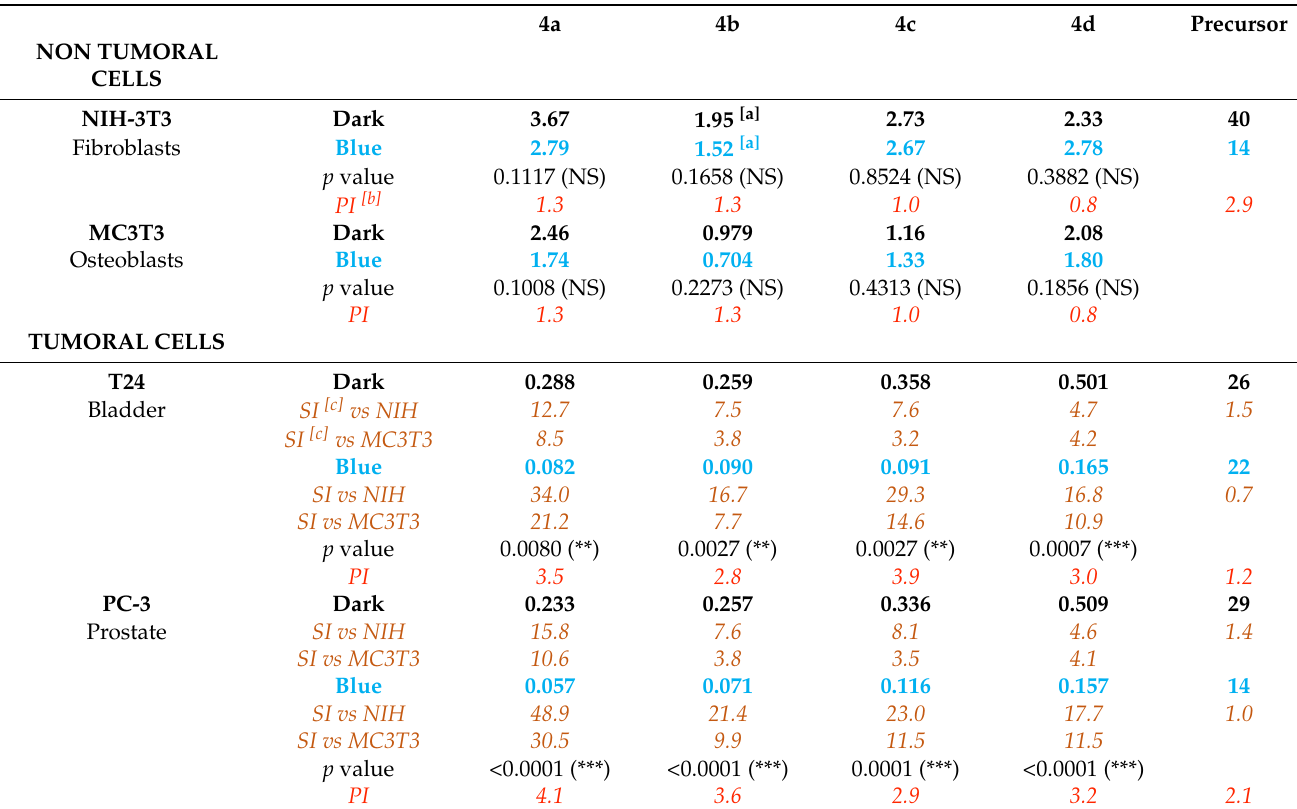
Table 2. Cytotoxicity and selectivity of complexes 4a to 4d on a panel of cancer cells (T24 bladder, PC-3 prostate, MCF7 breast, A549 lung and HeLa cervix) versus non-cancerous NIH-3T3 fibroblasts and MC3T3 osteoblasts (GI 50 ( µ M), 72 h, MTT